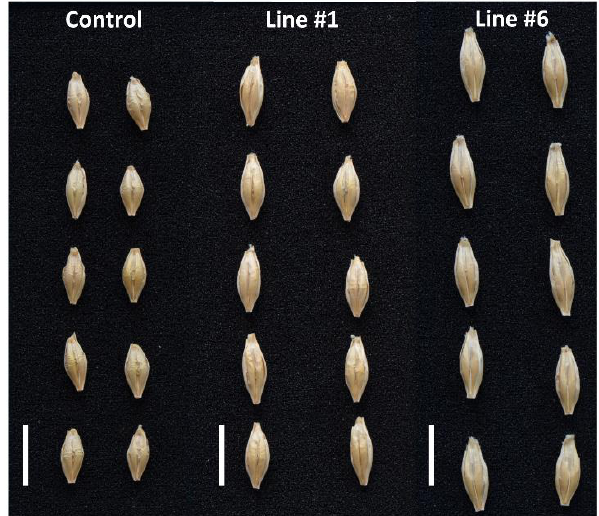
Figure 7. Representative pictures of kernels of the non-transgenic control and the transgenic lines #1 and #6.